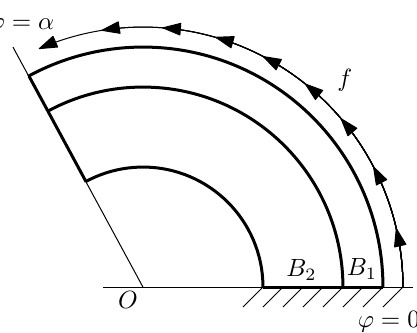
Figure 19: Two-layer curved composite beam uniformly loaded by tangential forces.